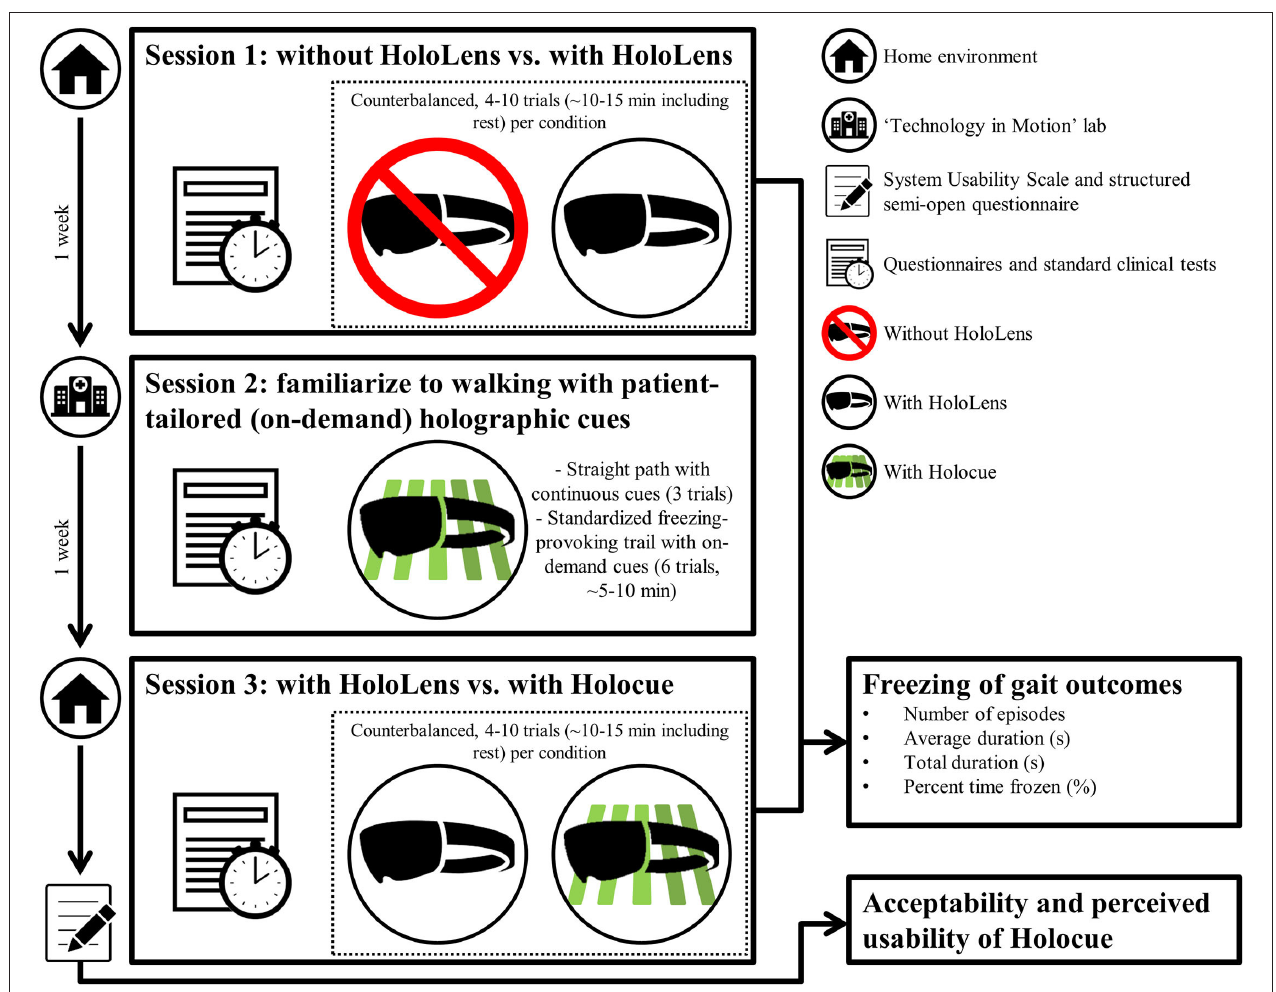
FIGURE 2 | Overview of the sessions (see Supplementary Material 1 for the detailed experimental protocol). Sessions were scheduled one week apart and lasted about